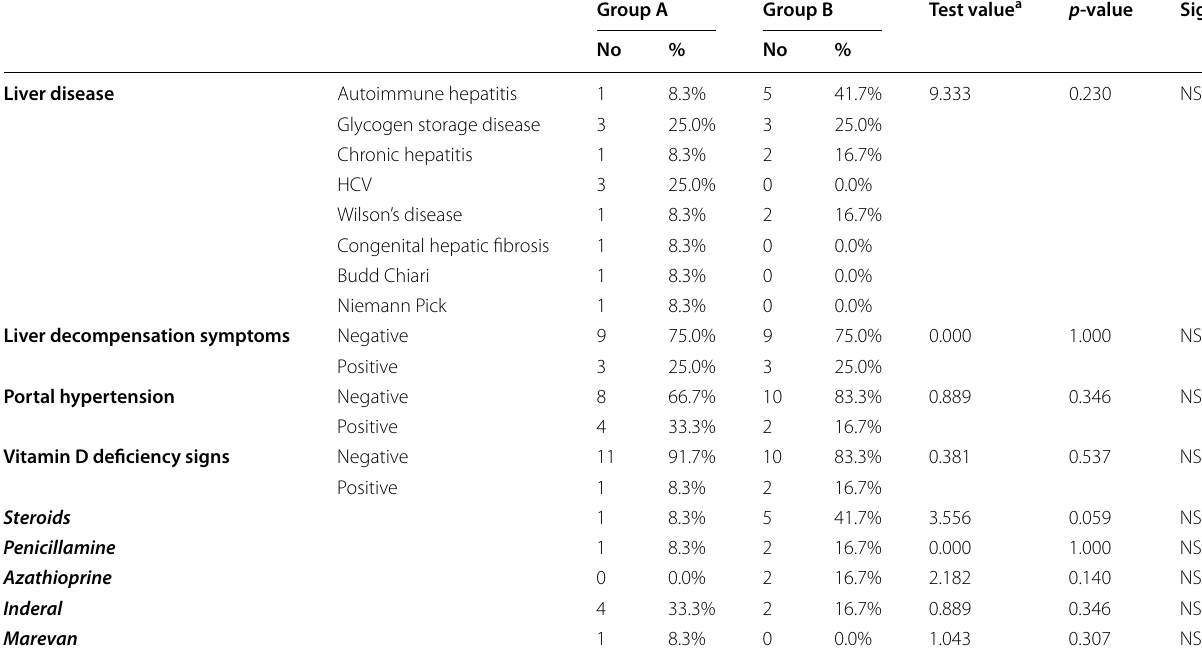
Table 4 Comparison between groups A and B regarding aetiology of liver disease, liver decompensation, complications and drug medication